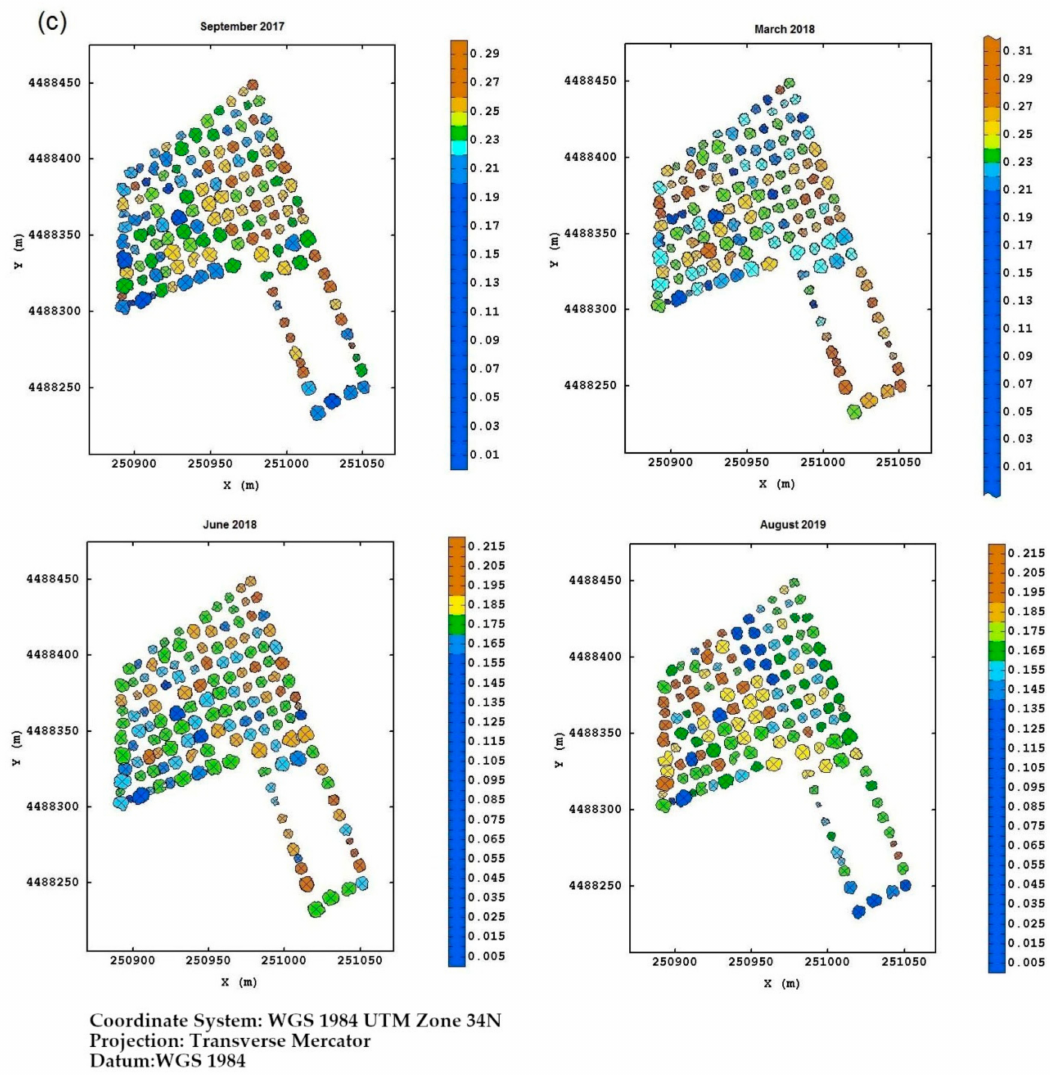
Figure 8. ( a ) Temporal red-edge reflectivity maps at plant quadrant level for the Re field. In this figure, and the following ones, the color scale is on isofrequency classes to enhance the differences. ( b ) Temporal red-edge reflectivity maps at plant quadrant level for the Fella field. ( c ) Temporal red-edge reflectivity maps at plant quadrant level for the Torchiarolo